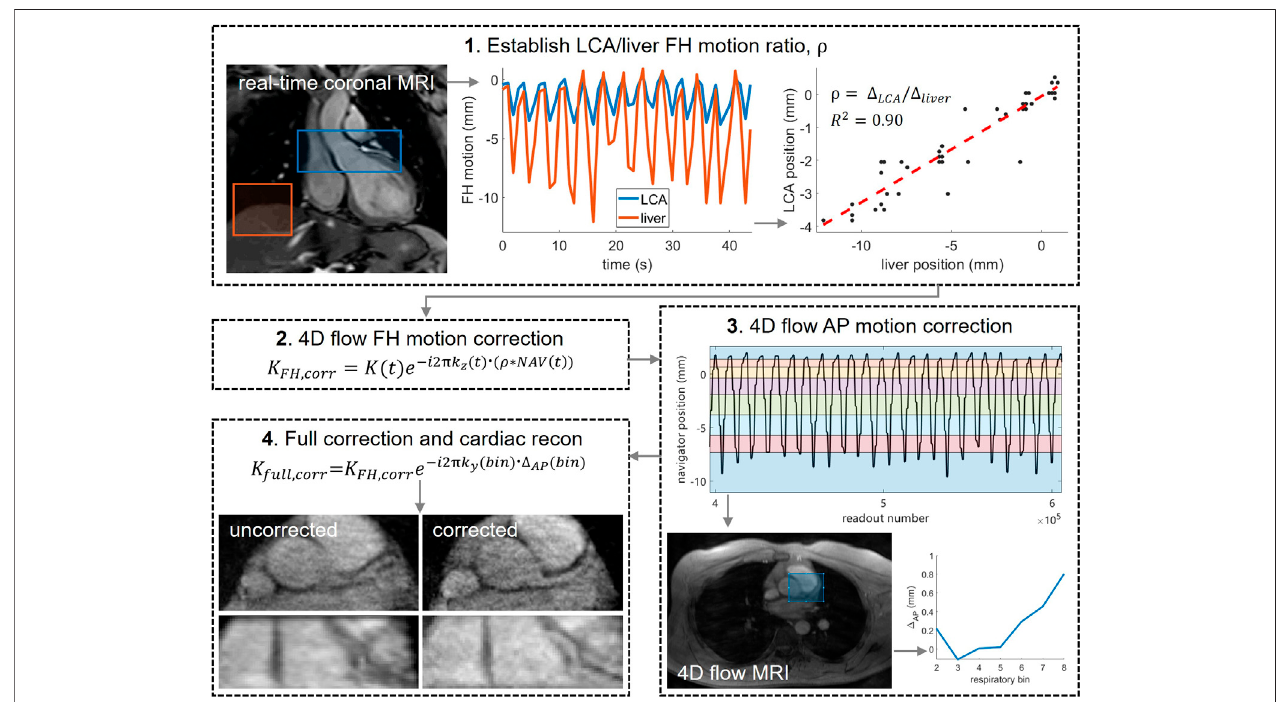
FIGURE 1 | Post-processing pipeline used to correct for respiratory motion in the 4D fl ow MRI acquisitions. 1) a real-time ECG-triggered scan was used to determine theratio ρ betweenthemotion ofLCA and livermotionin foot-head (FH)direction.Motioncurves weredeterminedbyrigid image registration on twoseparate regionsofinterest:overtheLCA(blue)andovertheliver(red).LCAandliverpositionswereplottedagainsteachotherandalinear fi twasmade,theslopeofwhichisequal to ρ . 2) LCA offsets, calculated by multiplying liver offsets NAV ( t ) with ρ , were converted into time-dependent phase shifts by multiplying the normalized k-space coordinate in the FH direction k z (t) with the corresponding LCA offset. The complex raw k-space data K (t) was then multiplied with these phase shifts. 3) NAV (t) was binned into 8 respiratory phases with equal amounts of data and bin-speci fi c images (time-averaged over mid-diastolic time frames) were reconstructed from the FH motion-correctedrawdata.Rigidimageregistrationofbins2 – 8tobin1(end-expiration)wasperformedoveracentralregionincludingtheLCA,producingAPoffsetsper bin. 4) AP offsets were corrected in the complex raw k-space data and fi nal image reconstruction was